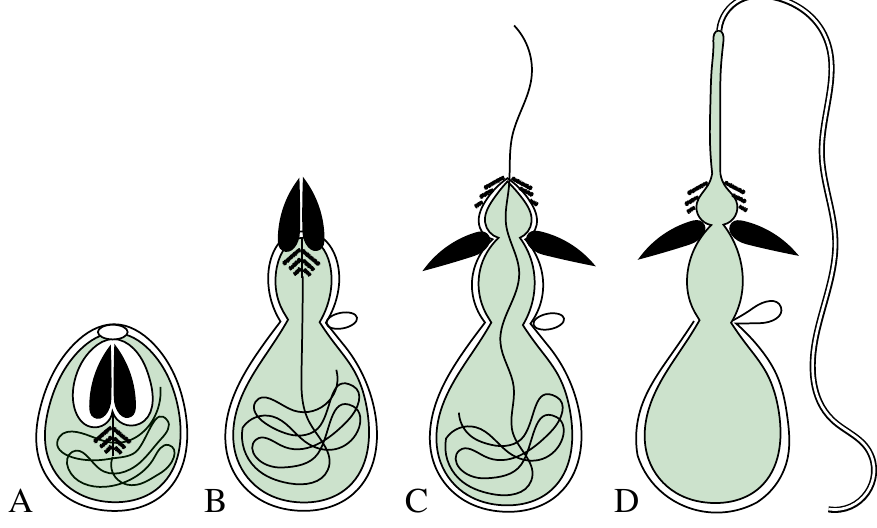
Figure 2. Stages of (stenotele) nematocyst discharge: ( A ) before discharge, ( B ) the operculum, denoted by an oval, opens allowing the large stylets to discharge, ( C ) Stylets puncture the prey, then evaginates into the prey, and ( D ) The tubule enters the prey and fills with the internal liquid matrix from the nematocyst. The light green color indicates the nematocyst matrix, and the thick straight lines represent the evaginating lamellae that clear the path for the slender tube [7]. The entire process takes less than 0.03